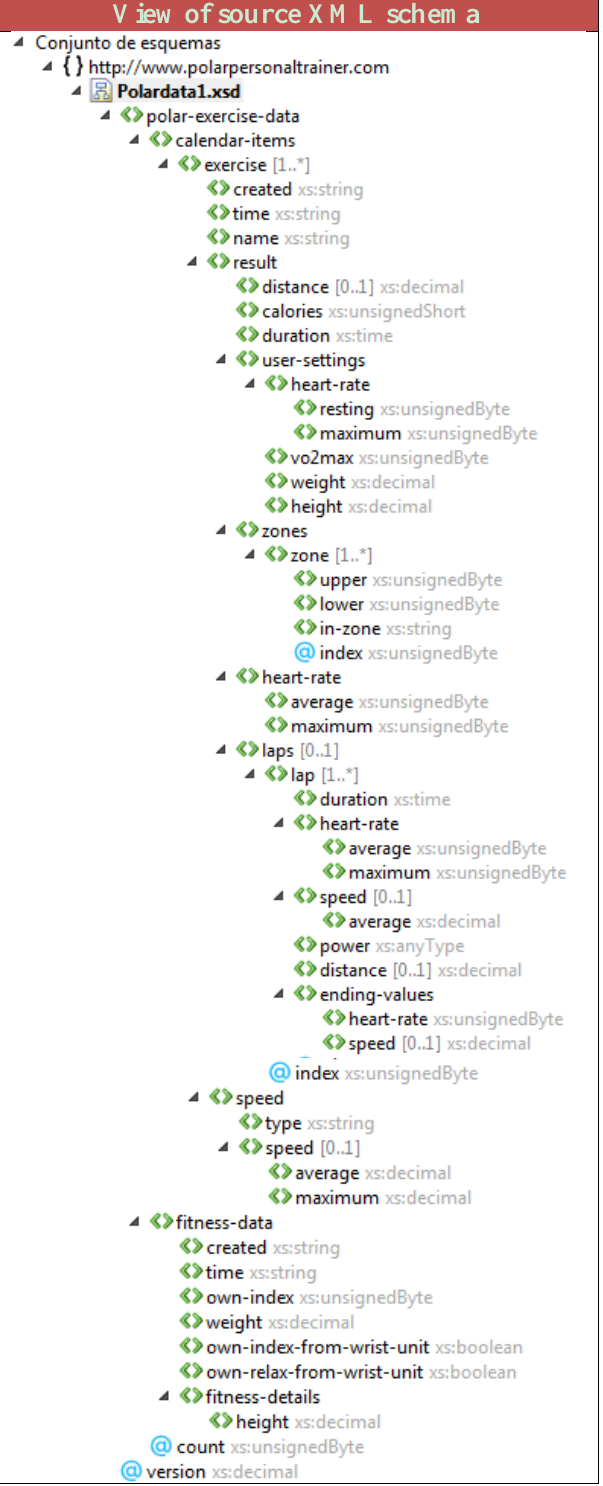
Table 2. Partial view of source XML